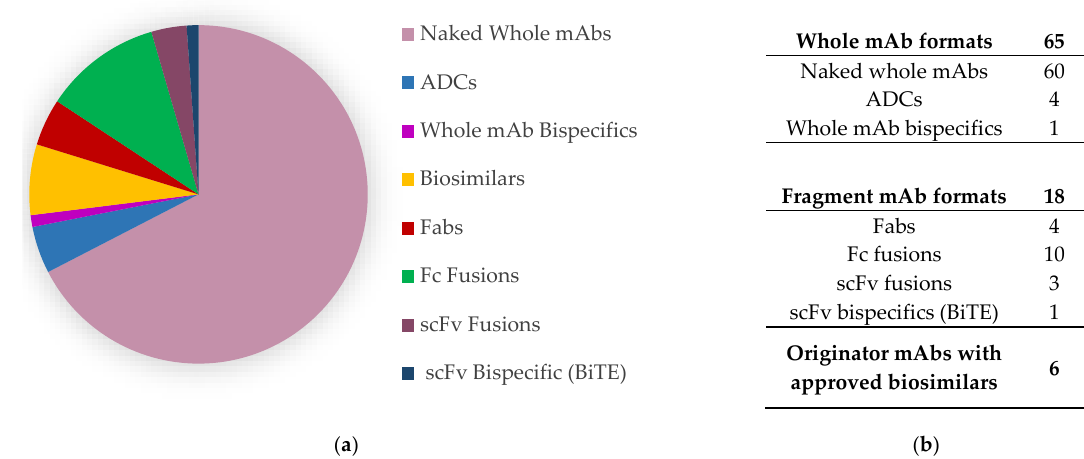
Figure 1. The proportions of therapeutic antibody formats approved for therapeutic use as of December 2018 , IMGT ® depicted through ( a ) a pie chart and ( b ) a table